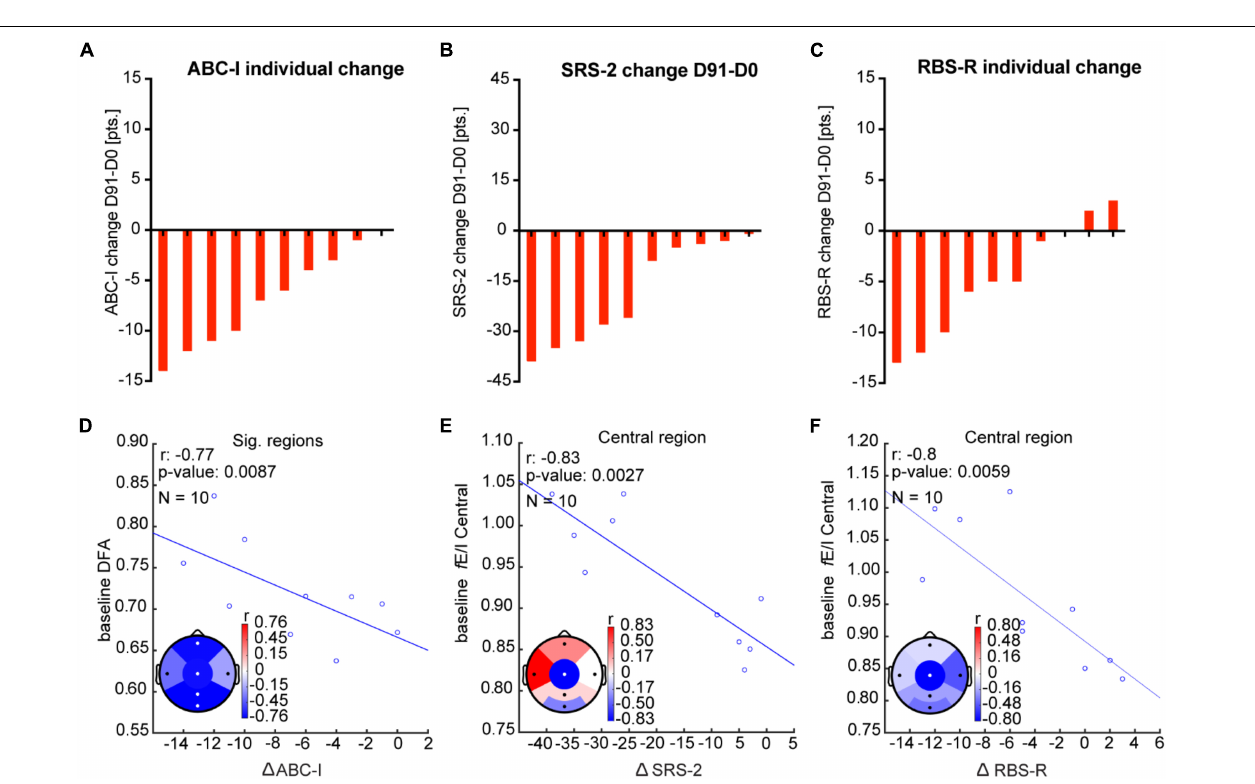
FIGURE 4 | Change in absolute power after bumetanide shows a moderate, albeit non-significant, correlation with improvement in repetitive behavior. (A) Rank-ordered change in RBS-R in response to bumetanide for each participant (D91-minus-D0). (B) A moderate correlation, yet non-significant, was observed between an increment in absolute power and improvement in repetitive behavior after bumetanide (RBS-R), specifically in the right temporal region.